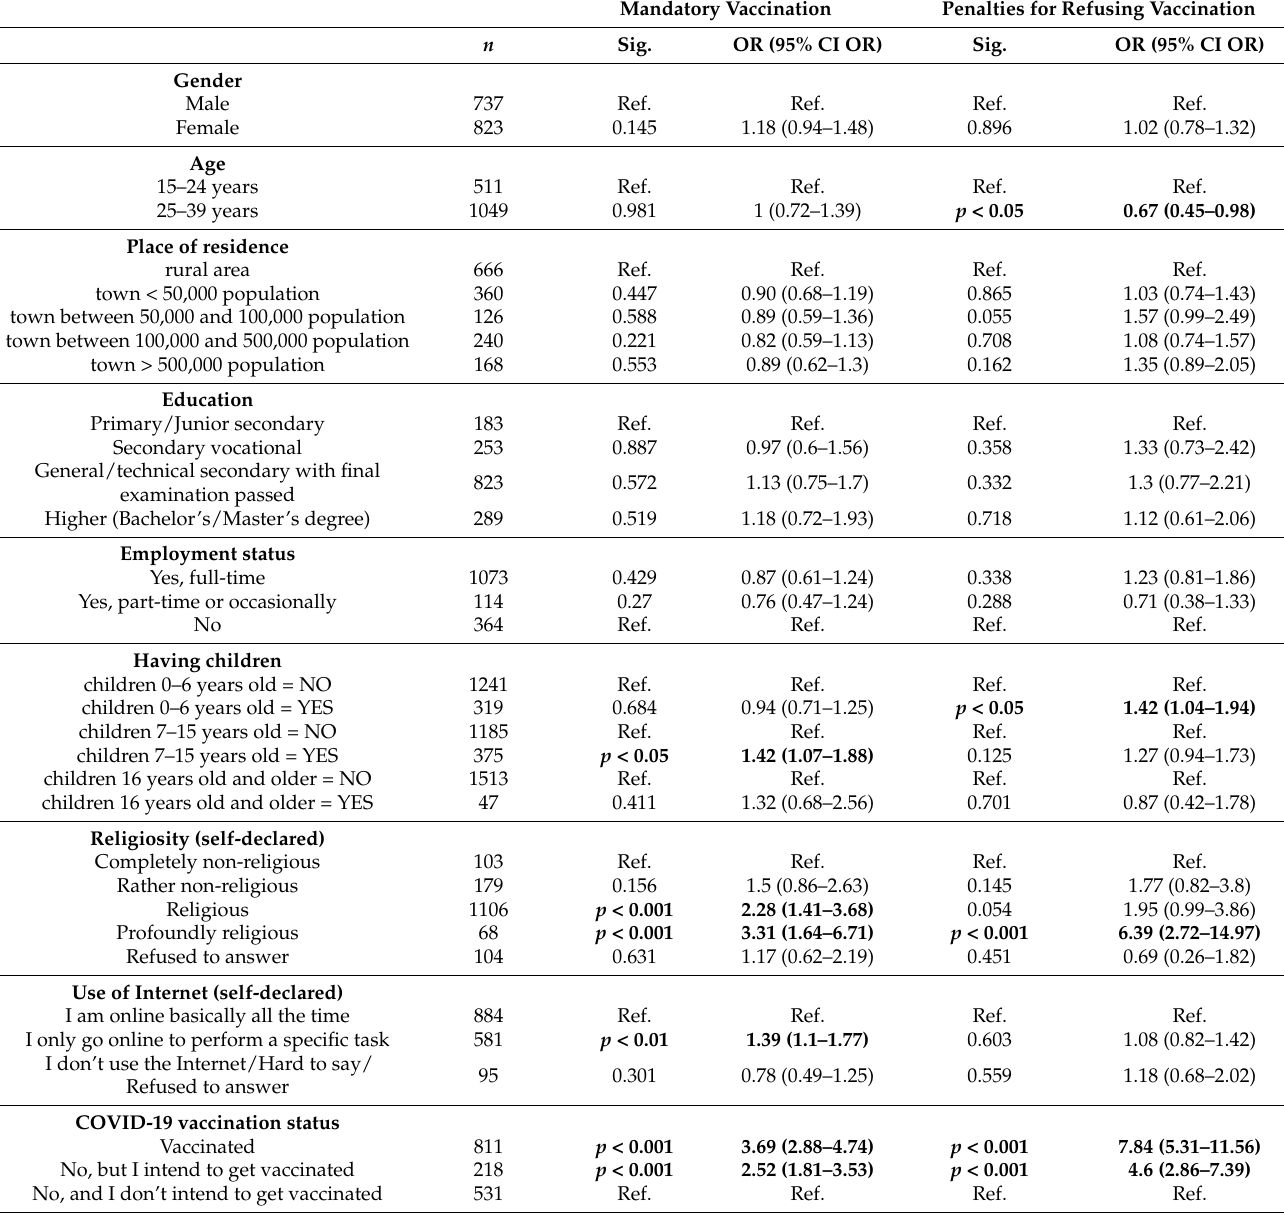
Table 2. Influence of selected factors on support for mandatory vaccination against the most danger- ous infectious diseases. A multivariate logistic regression model ( n =